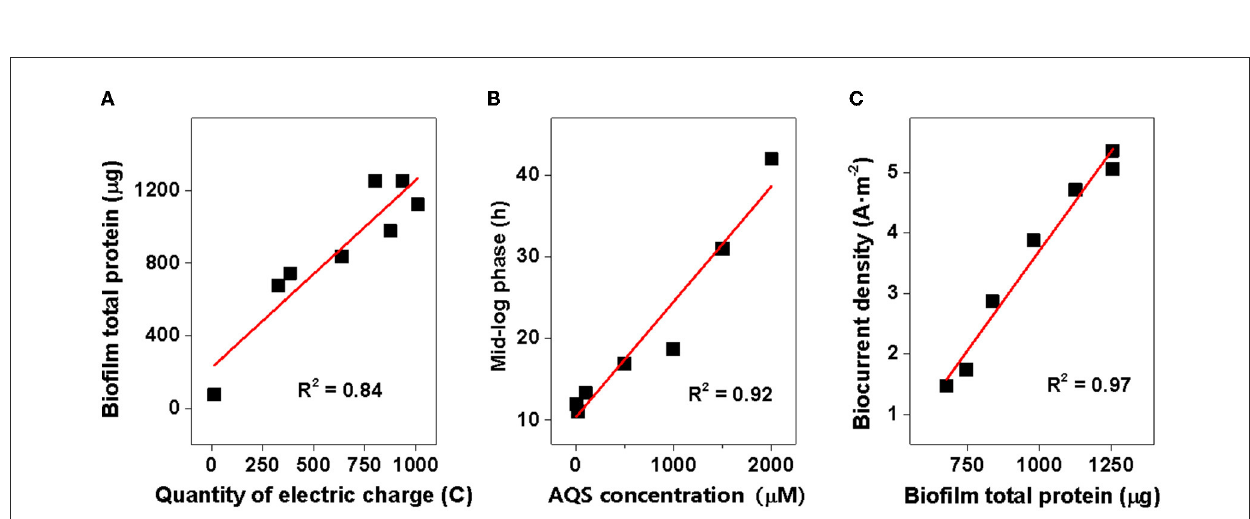
FIGURE5 Correlation analysis. (A) Total protein of biofilms vs. quantity of electric charge; (B) time of mid-log phase vs. 9,10-anthraquinone-2-sulfonic acid (AQS) concentration; and (C) biocurrent density vs. biofilm total